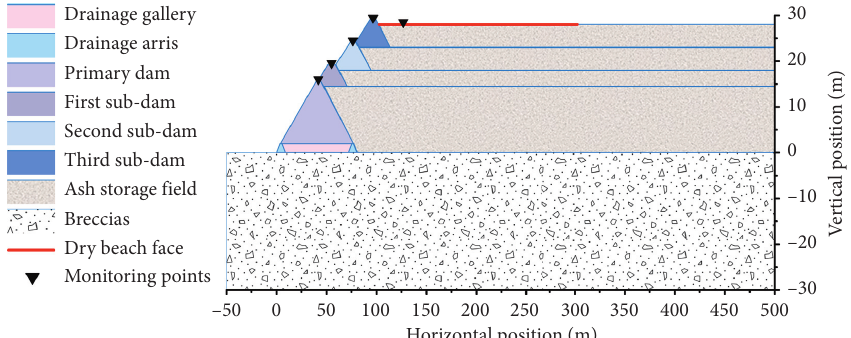
K s and a . (a) Variation of